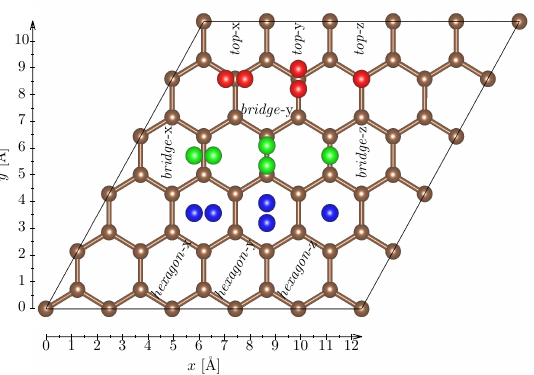
Figure 1. Schematic view of different (high-symmetry) sites for placing hydrogen molecule on graphene (top-red configurations, bridge-green configurations and hexagon-blue